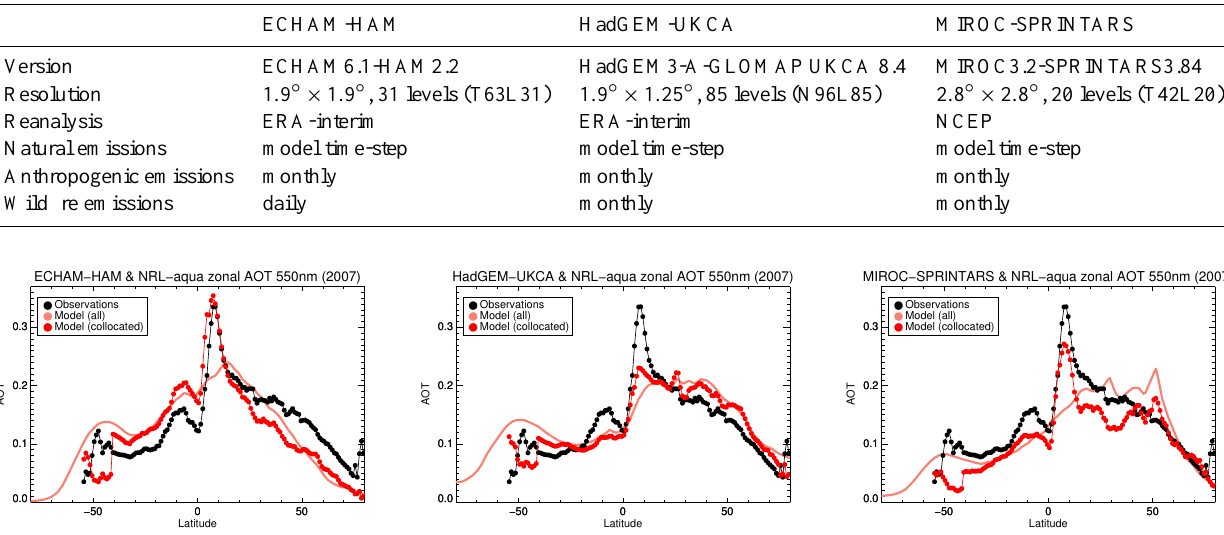
Figure 1. Yearly and zonal averages of AOT from the observations (MODIS-NRL Aqua) and the models. The latter are averaged in two different ways: using either all model data or only those sampled at the observation